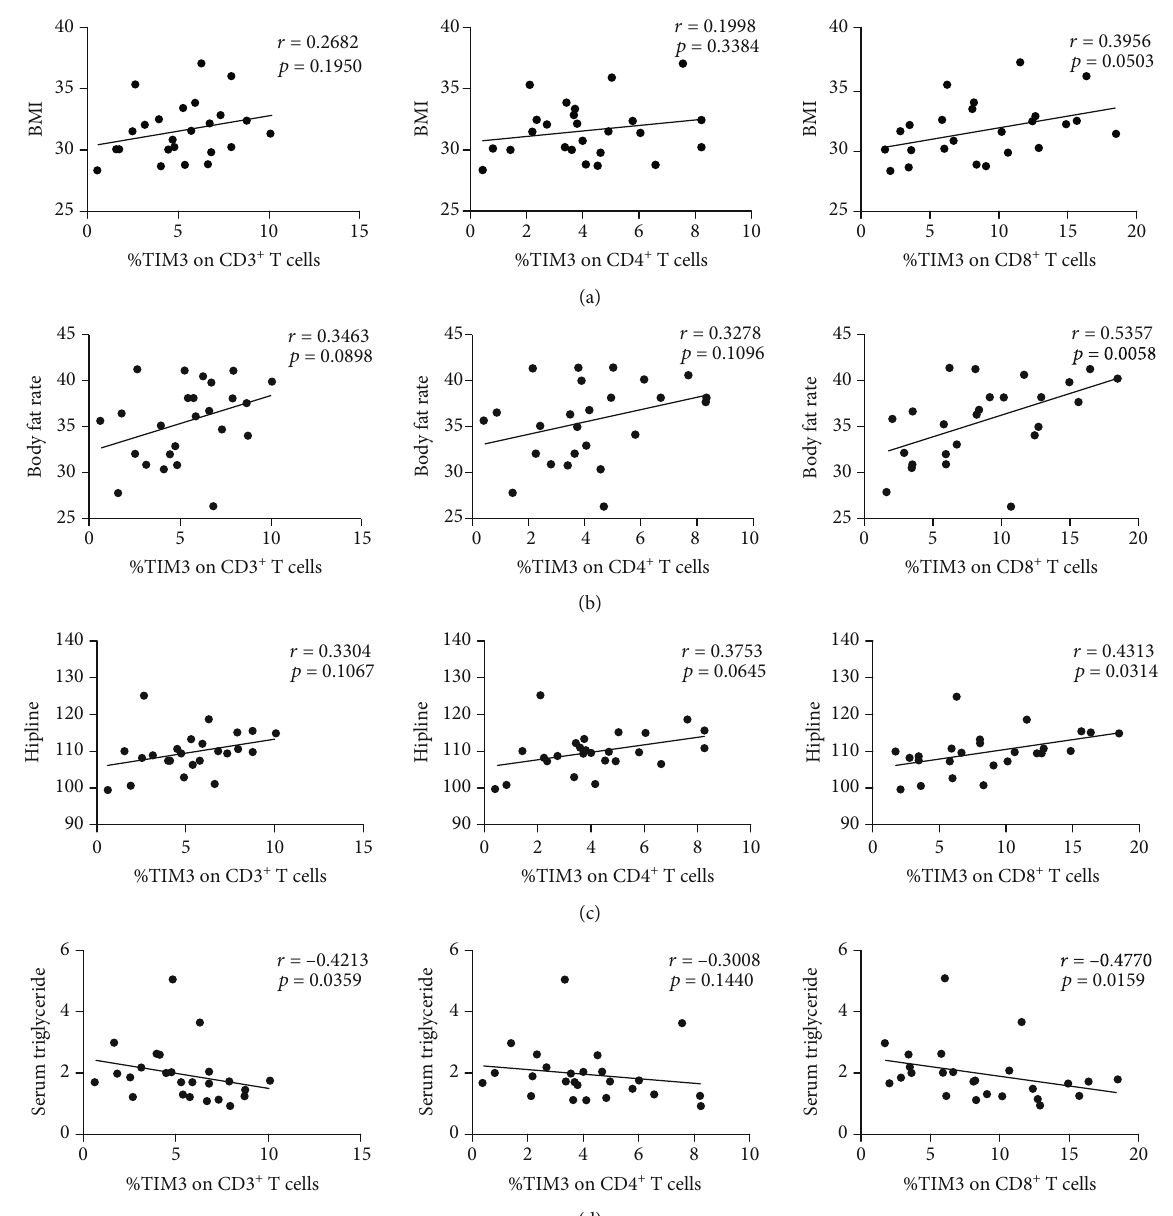
Figure 2: Correlation analyses between TIM3 expression and clinical indicators in obesity patients. Correlation analysis of TIM3-positive cells and BMI (a), body fat rate (b), hipline (c), and triglyceride